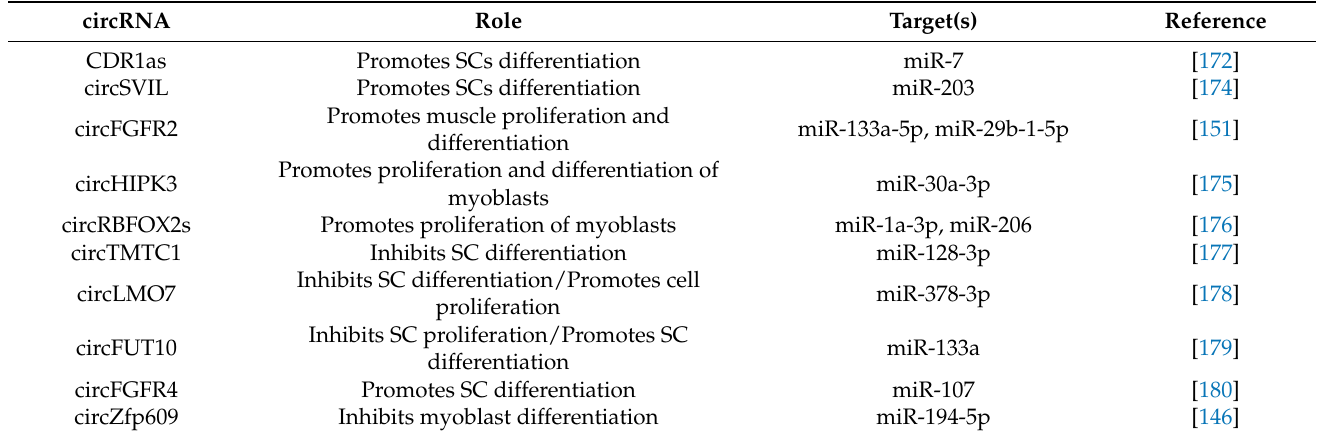
Table 7. Circular RNAs in myogenesis